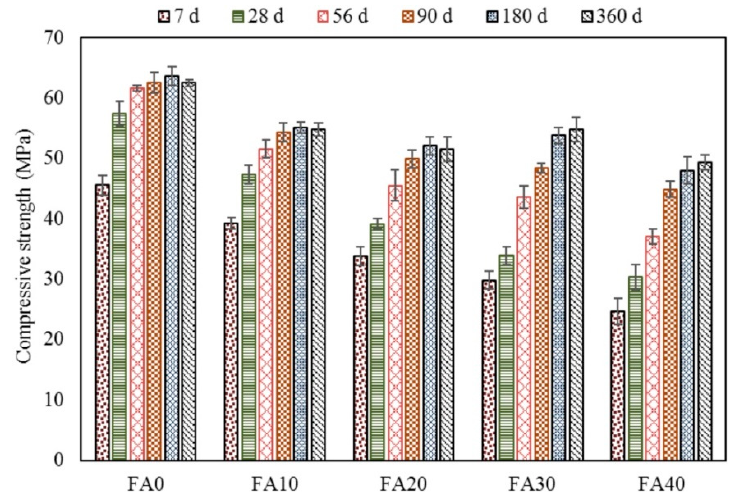
Figure 6. Compressive strength development [75].